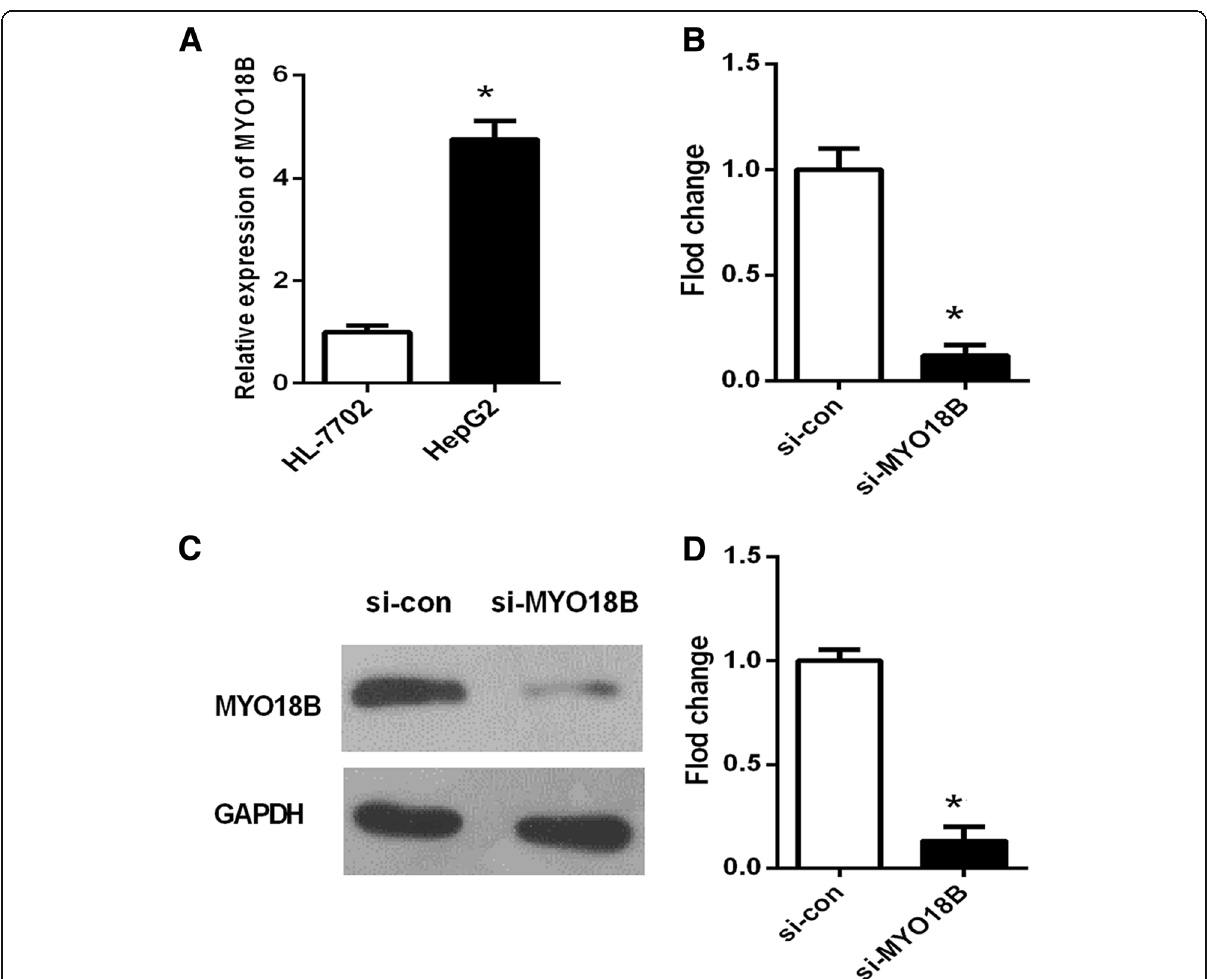
Fig. 2 Relative MYO18B expression in hepatocellular carcinoma cells. a The expression levels of MYO18B in HepG2 and HL-7702 cell lines were analyzed by qRT-PCR. MYO18B expression displayed a higher level in HepG2 cells. b - d HepG2 cells were transfected with one specific siRNA (experimental group, si-MYO18B) or non-specific control siRNA (negative control group, si-con). MYO18B expression was determined by qRT-PCR ( b ) and western blot ( c , d ) respectively. * P < 0.05 versus si-con